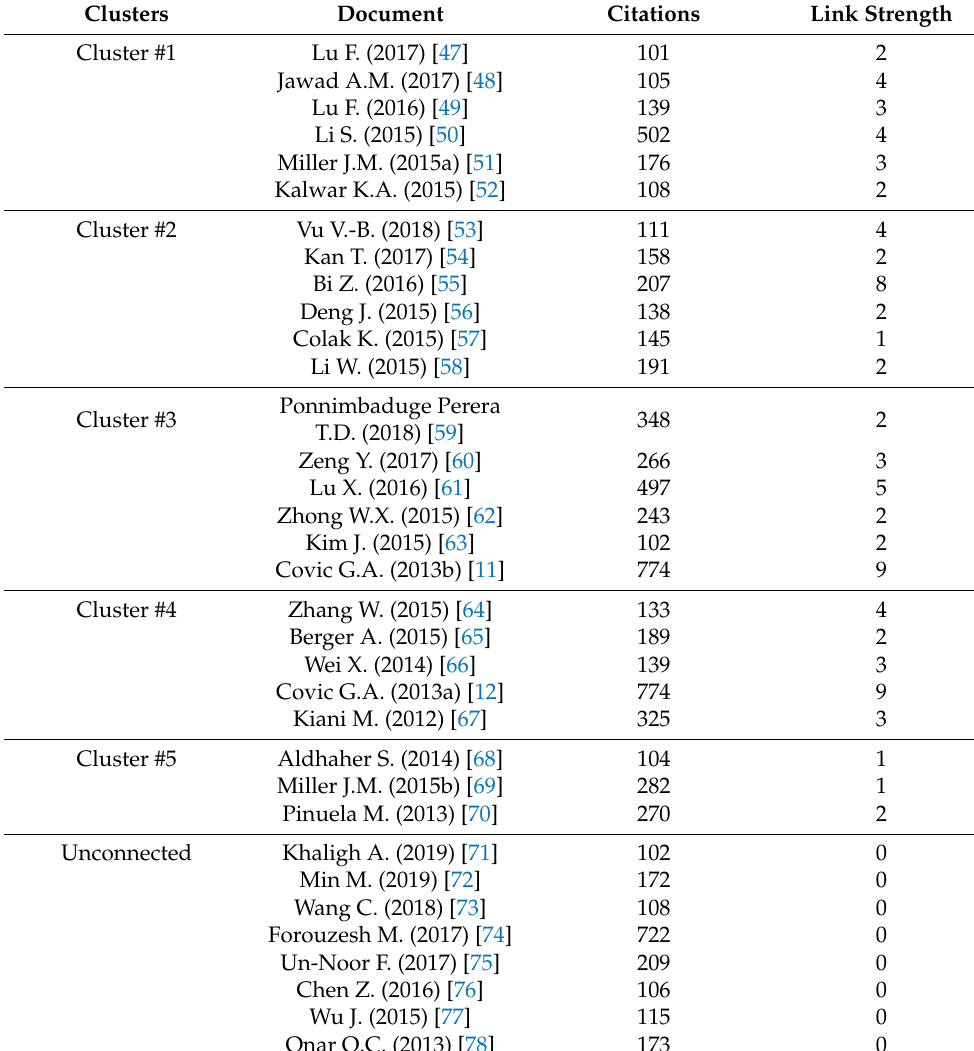
Table 4. Citation Analysis—List of Cited Documents and Their Citation Counts with Number of Links Formed in the Network.